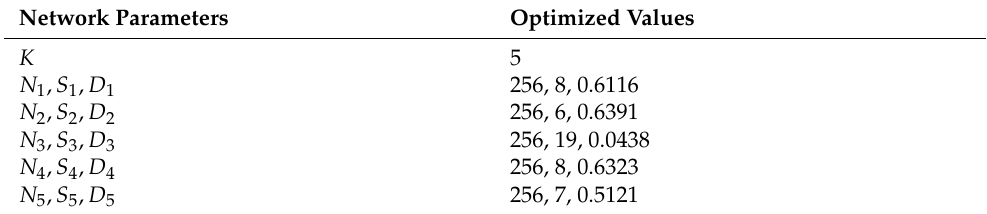
Table 4. Optimized parameters of the network architecture shown in Figure Table 4 . Optimized parameters of the network architecture shown in Error! Reference source not found. .